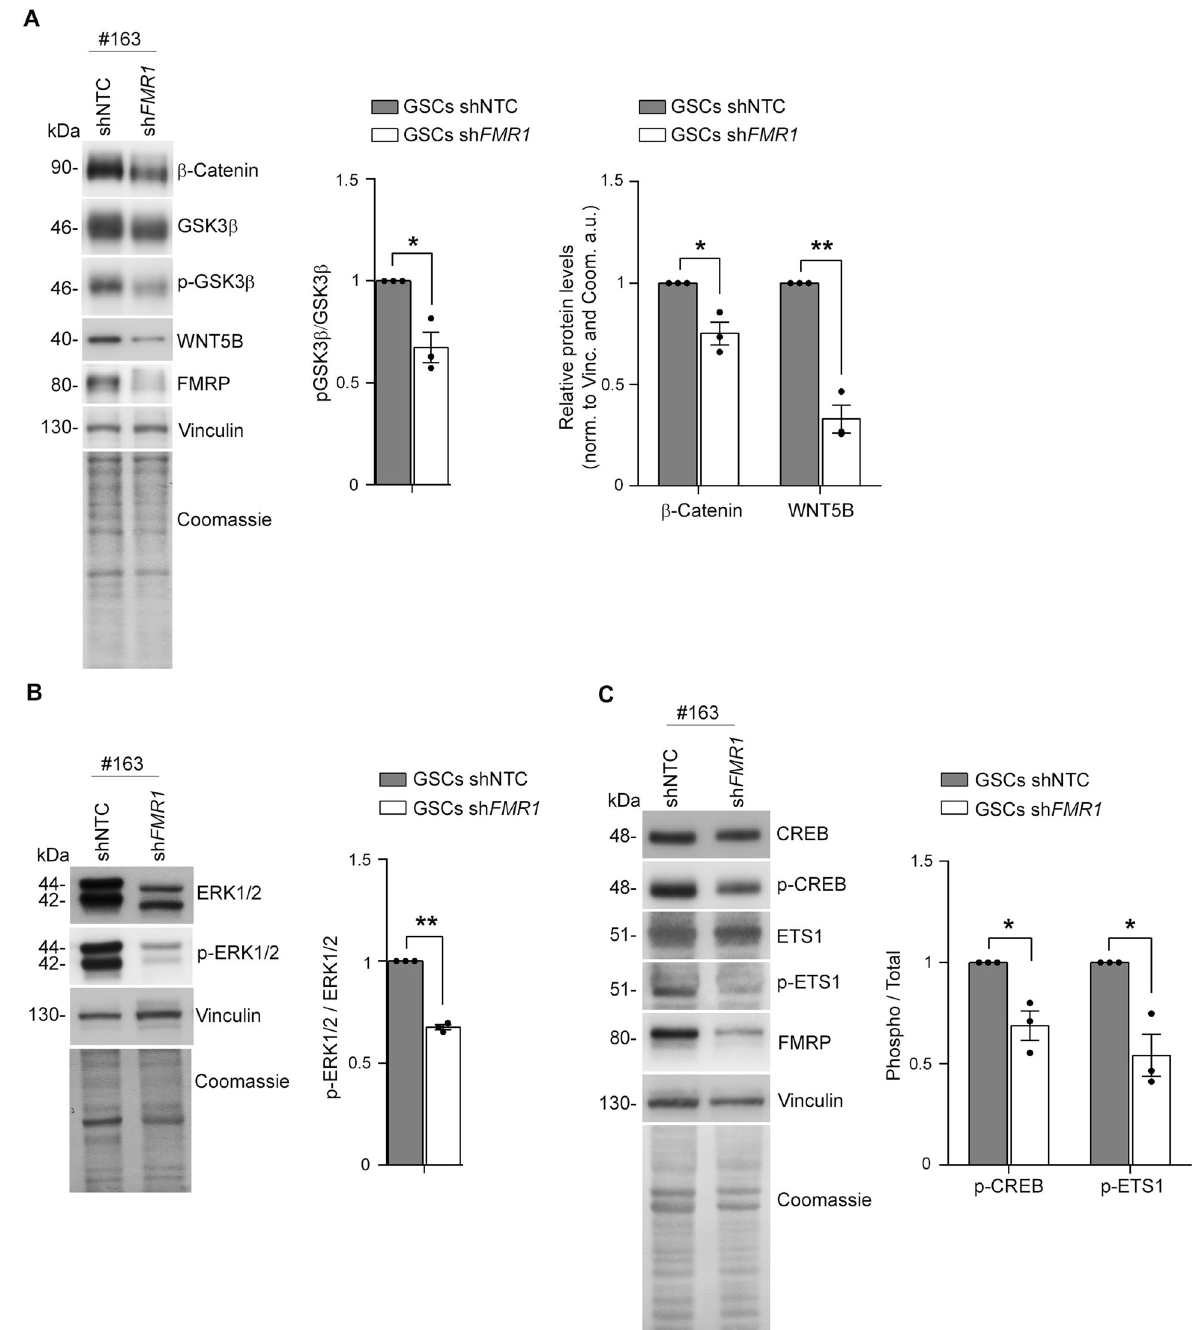
Fig. 5 FMRP modulates the WNT canonical and non-canonical pathways. A Left panel shows representative western blot of β -Catenin, GSK3 β , and p-GSK3 β levels in GSCs transduced with shNTC and sh FMR1 . Vinculin and Coomassie staining were used as normalisers. Right histogram represents the quanti fi cation of the biological replicates of p-GSK3 β , β -Catenin and WNT5B (#148, #163, and #169 GSCs). p-GSK3 β was normalised over total GSK3 β levels (mean ± SEM, n = 3 independent cell lines, each data point averaged from three FACS sortings, ** P < 0.01, *** P < 0.001, One-sample t -test). B Left panel shows representative western blot of ERK1/2 and p-ERK1/2 levels in GSCs transduced with shNTC and sh FMR1 . Vinculin and Coomassie staining were used as normalisers. Right histogram represents the quanti fi cation of the biological replicates (#148, #163, and #169 GSCs). p-ERK1/2 was normalised over total ERK1/2 levels (mean ± SEM, n = 3 independent cell lines, each data point averaged from three FACS sortings, *** P < 0.001, One-sample t -test). C Left panel shows representative Western blot of CREB, p-CREB, ETS1 and p-ETS1 levels in GSCs transduced with shNTC and sh FMR1 . Vinculin and Coomassie staining were used as normalisers. Right histogram represents the quanti fi cation of the biological replicates (#148, #163 and #169 GSCs). Phosphorylated proteins were normalised over total protein levels (mean ± SEM, n = 3 different cell lines, each data point is the average of three independent FACS sortings, * P < 0.05, ** P < 0.01, One-sample t -test).